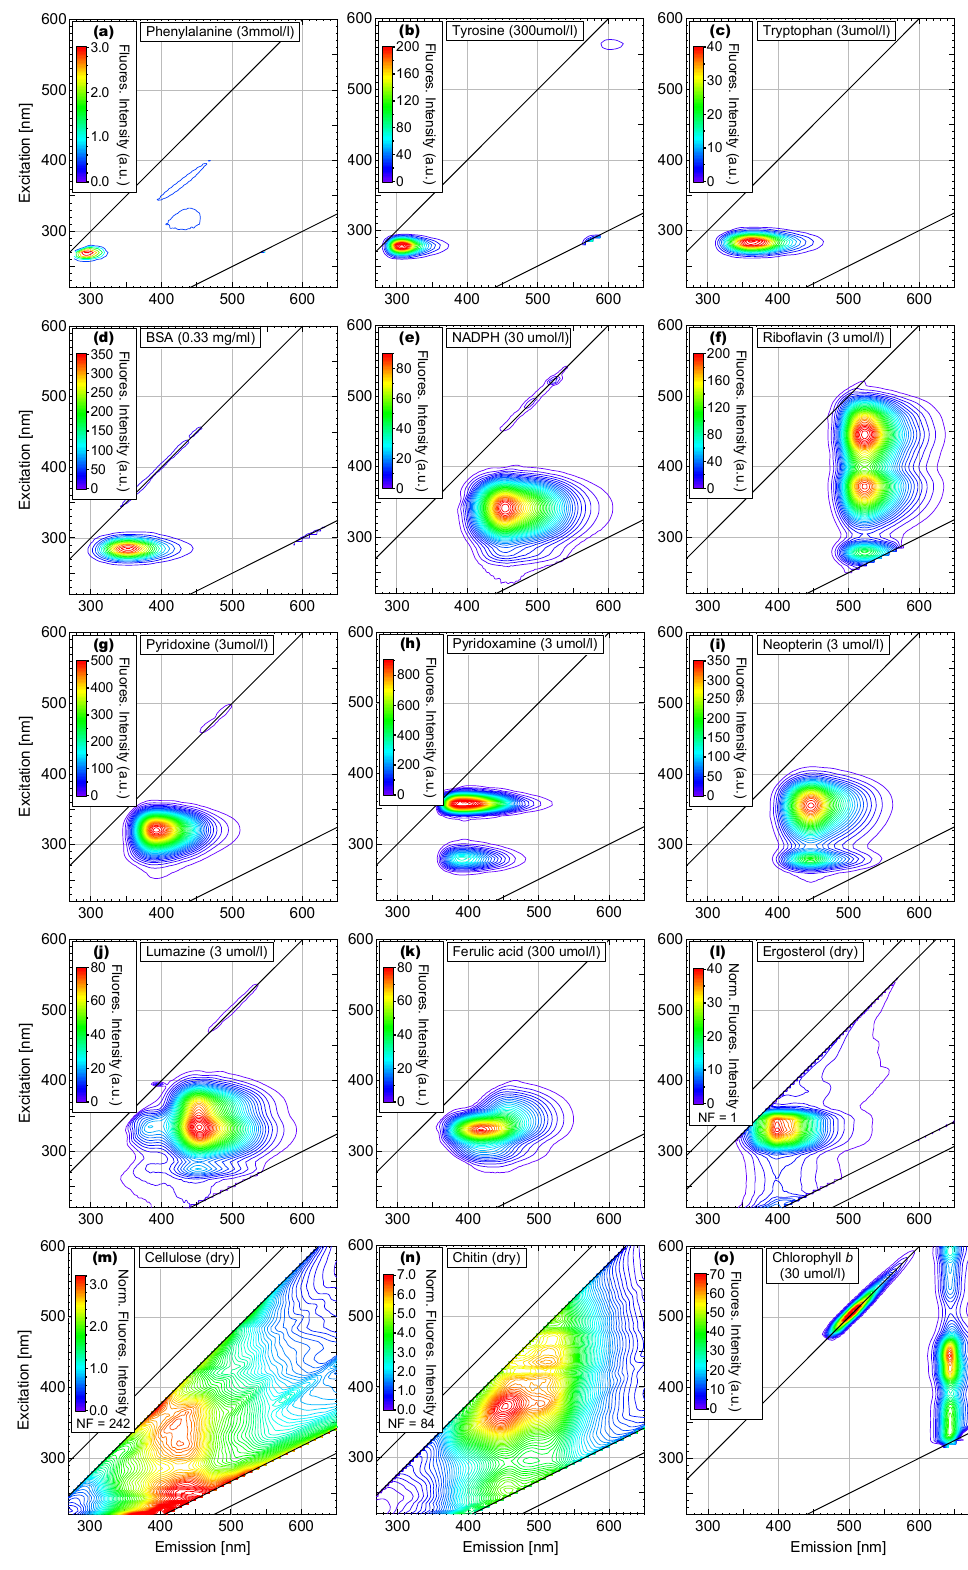
Fig. 2. EEM contour profiles for selected pure biological fluorophores in solid or solvated state. Intensity color scale has been adjusted to intensity of individual components. All EEMs are normalized as discussed in text (Sect. 3.2). Normalization factor (NF) is reported for each solid-state sample. Lower NF indicates higher fluorescence intensity. Note change in x-axis scale for chlorophyll- b